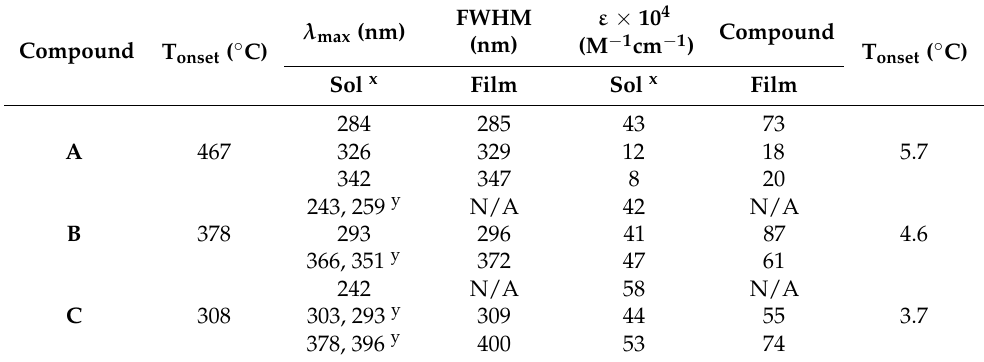
Table 1. Thermal and absorption spectra data summary for compounds A , B , and C .